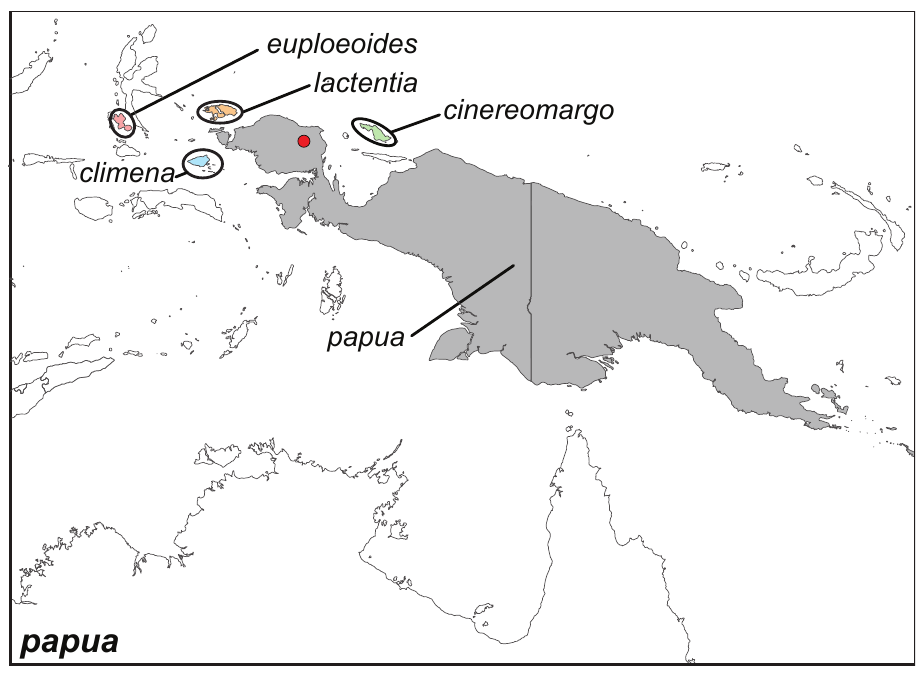
Figure 29. Distribution map of Elymnias papua.